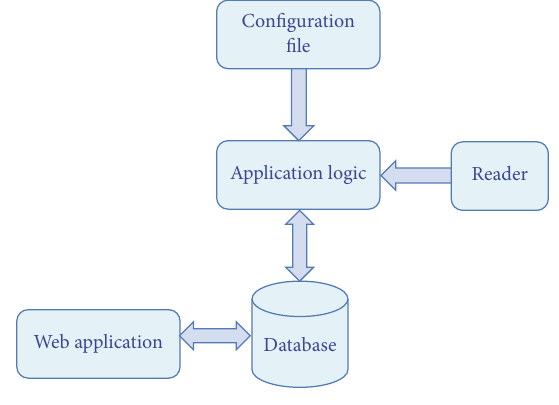
Figure 5: Program description.